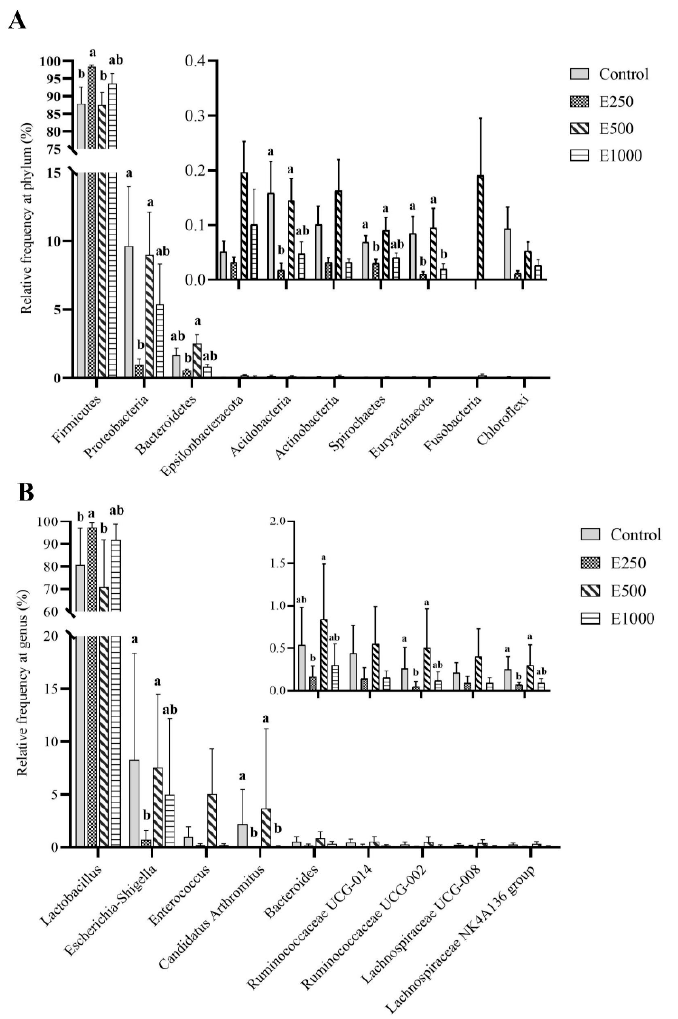
Figure 2. Composition of ileal microbiota at phylum ( A ) and genus ( B ) levels among different treatments. Ileal digesta samples were collected in the broilers at 42 days of age after feeding the basal diet supplemented with 0 (Control), 250 (E250), 500 (E500), or 1000 (E1000) U glucose oxidase/kg diet for 42 days. a,b Means ( n = 6) within a column lacking a common lowercase differ ( p < 0.05).